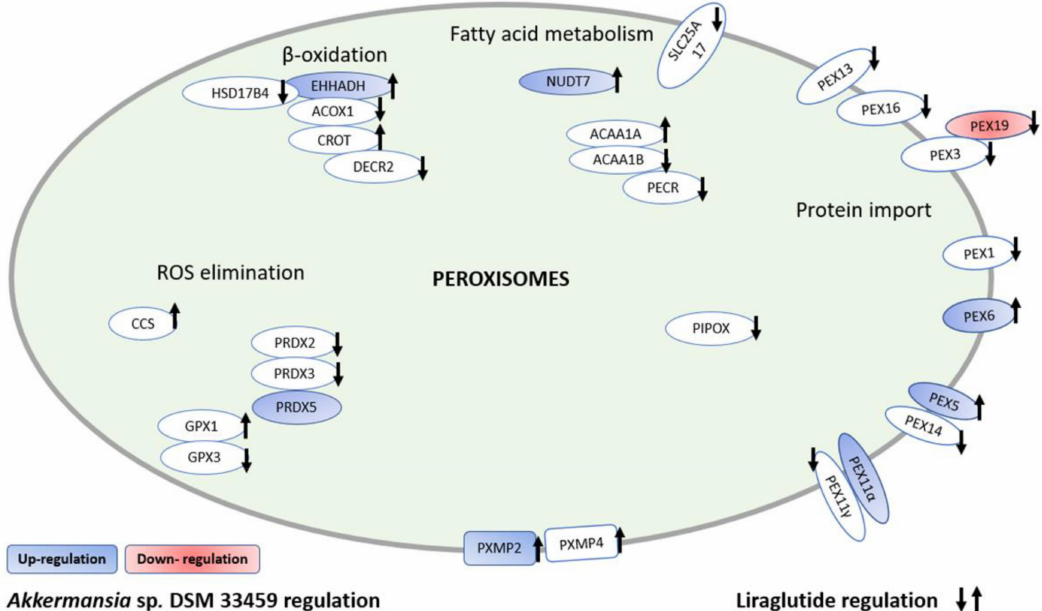
Figure 11. Similar modulation of peroxisomal proteins by Akkermansia sp. DSM 33459 and drug control